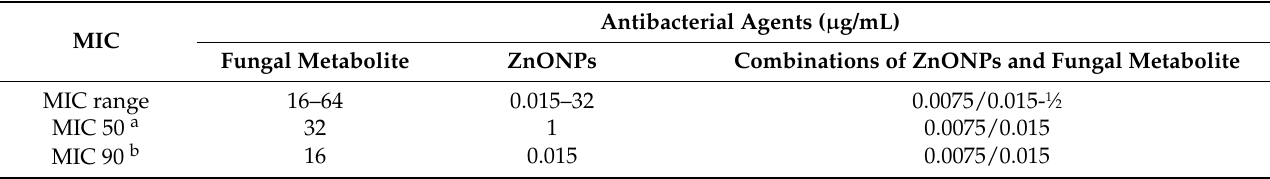
Table 4. MIC 50 and MIC 90 of the fungal metabolite, zinc oxide nanoparticles and their